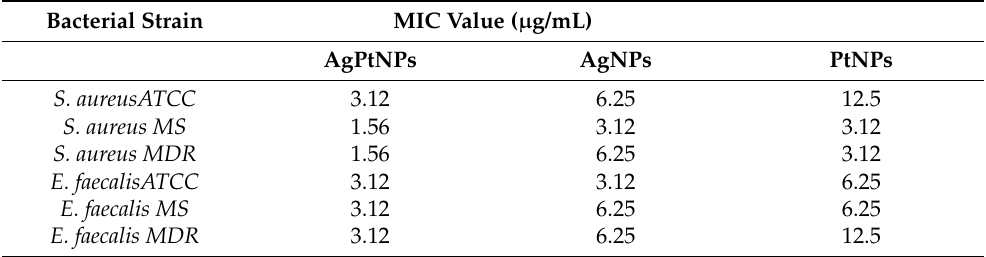
Figure 8. Analysis of AgPtNPs by MIC against ATCC, MS and MDR Gram-negative bacterial pathogens. ( A – C ) indicate the analysis against all E. coli and ( D – F ) against K. pneumoniae . Data are means of three independent experiments. Ctlr+ indicates bacteria treated with antibiotic, while Ctlr − represents not-treated bacteria. Data are relative to Ctlr – and represent the mean ± standard deviation (SD). Significant diff. among means (*** p < 0.05). Table 5. Minimum inhibitory concentration of bimetallic and monometallic NPs against all Gram- negative bacterial strains.